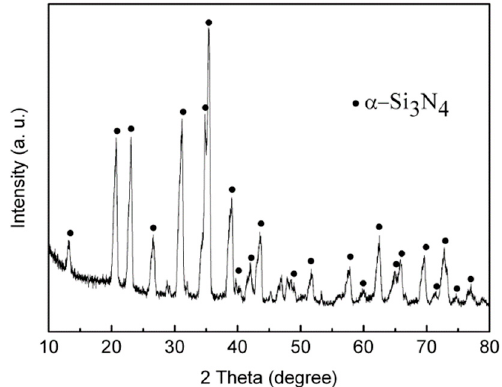
Figure 5. X-ray diffraction pattern of the fiber-like nitride Figure 5. X ‐ ray diffraction pattern of the fiber ‐ like nitride products.